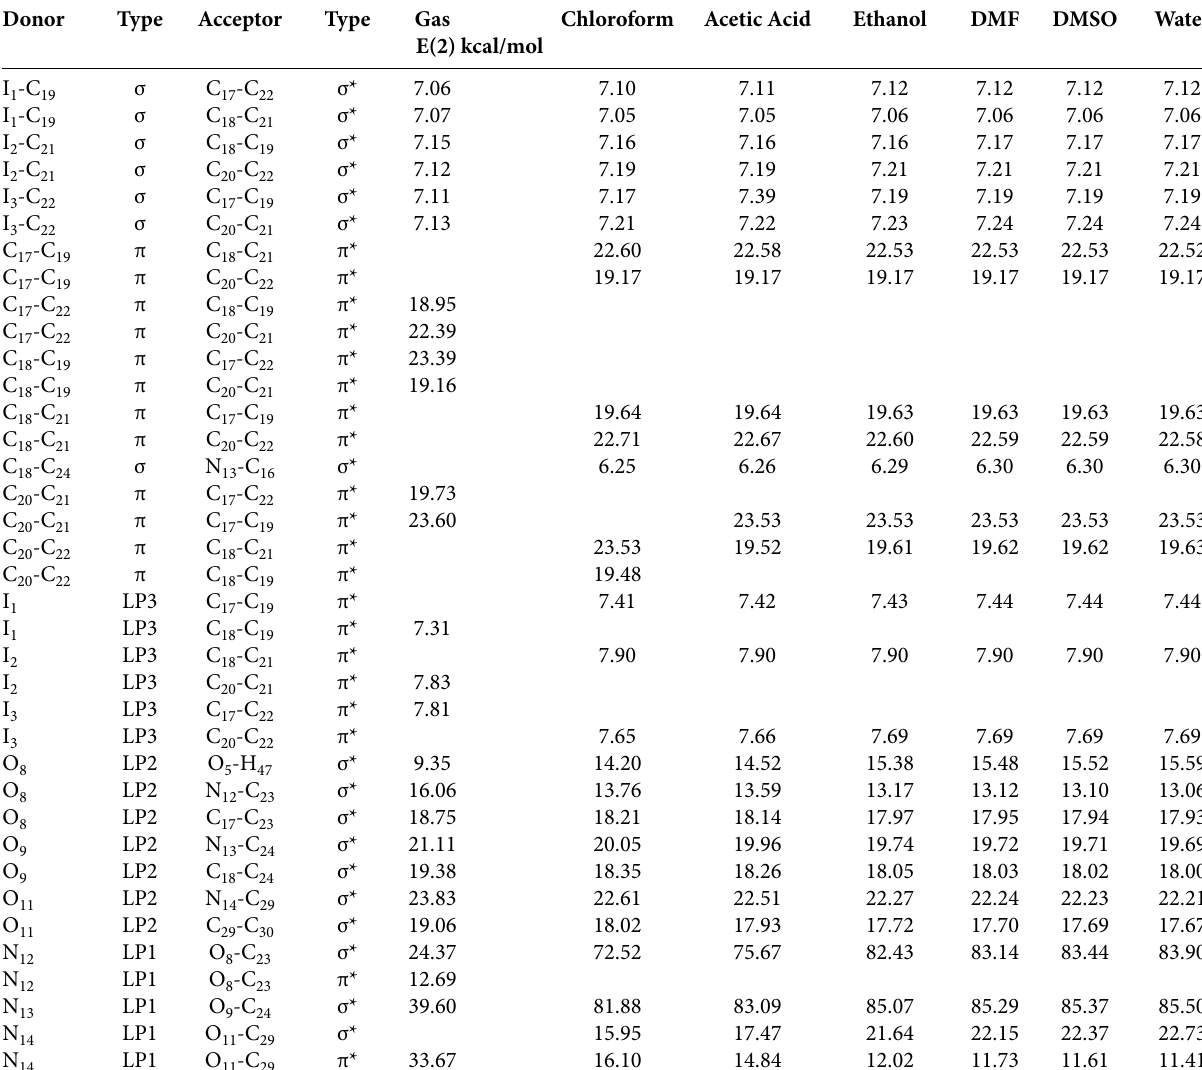
Table 8. Interaction energies of Iopamidol in gas phase and in different solvents. Donor